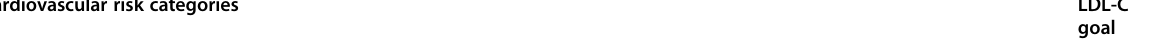
Table 1 Risk categories and LDL-C goals Cardiovascular risk